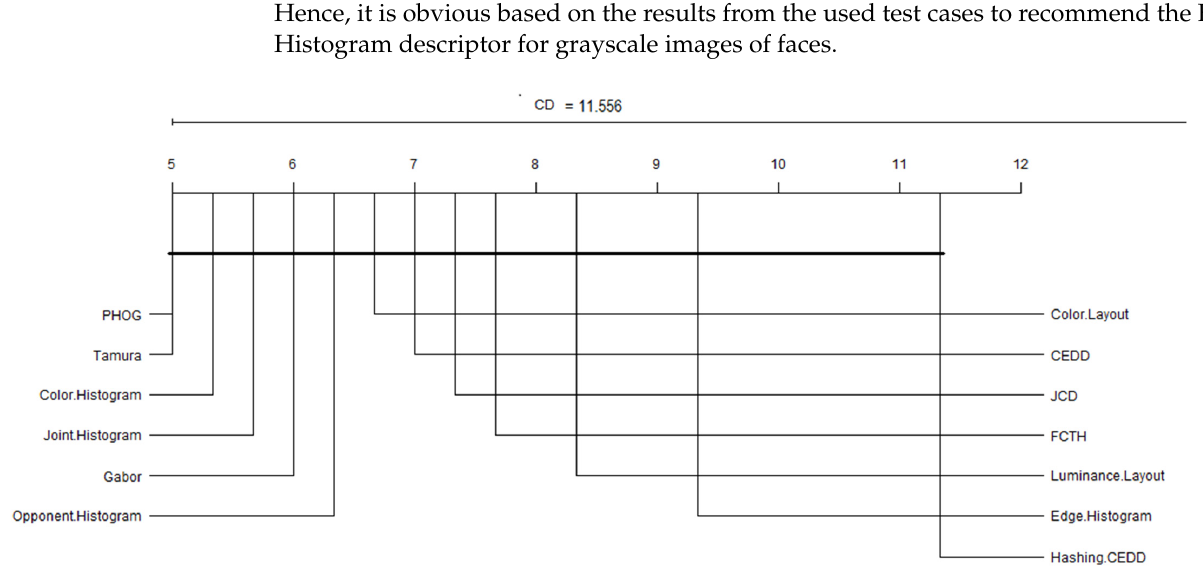
Figure 14. Critical Distance Diagram (CDD) for inverted face images.